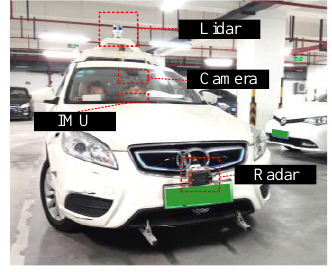
Figure 8. Physical test platform.